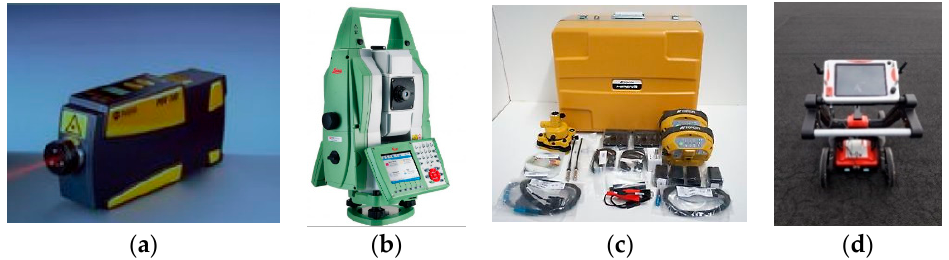
Figure 3. Measuring equipment used. ( a ) Polytec mobile doppler vibrometer-Germany (Waldbronn), ( b ) Leica TS50-Swisserland (Heerbrugg, ( c ) Topcon global navigation satellite system (GNSS)-Japan (Tokio), ( d ) ground-penetrating radar (GPR MALA)-Australia (Brookvale).